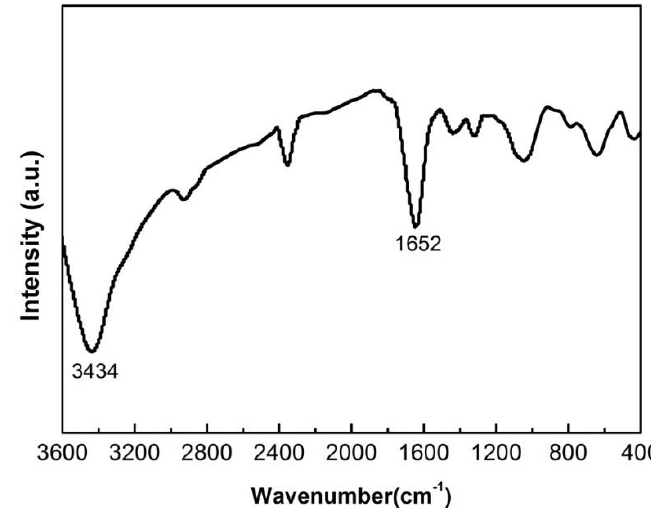
Figure 2. The FT-IR plot of the precursor from the chemical co-precipitation method.